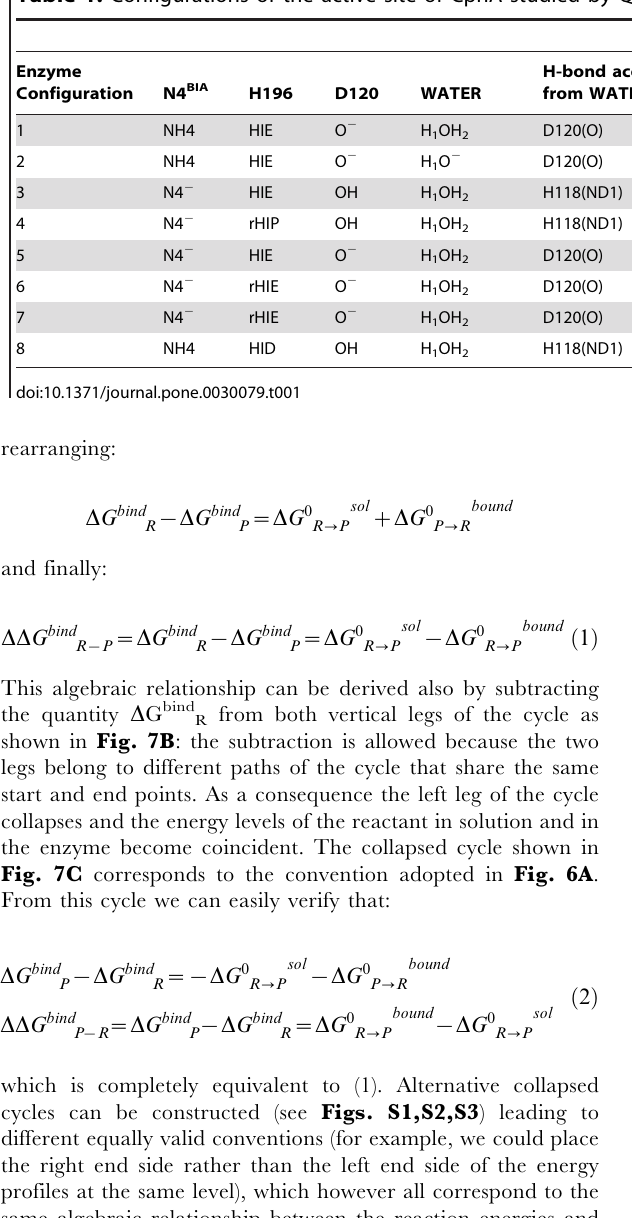
Table 1. Configurations of the active site of CphA studied by QM/MM.